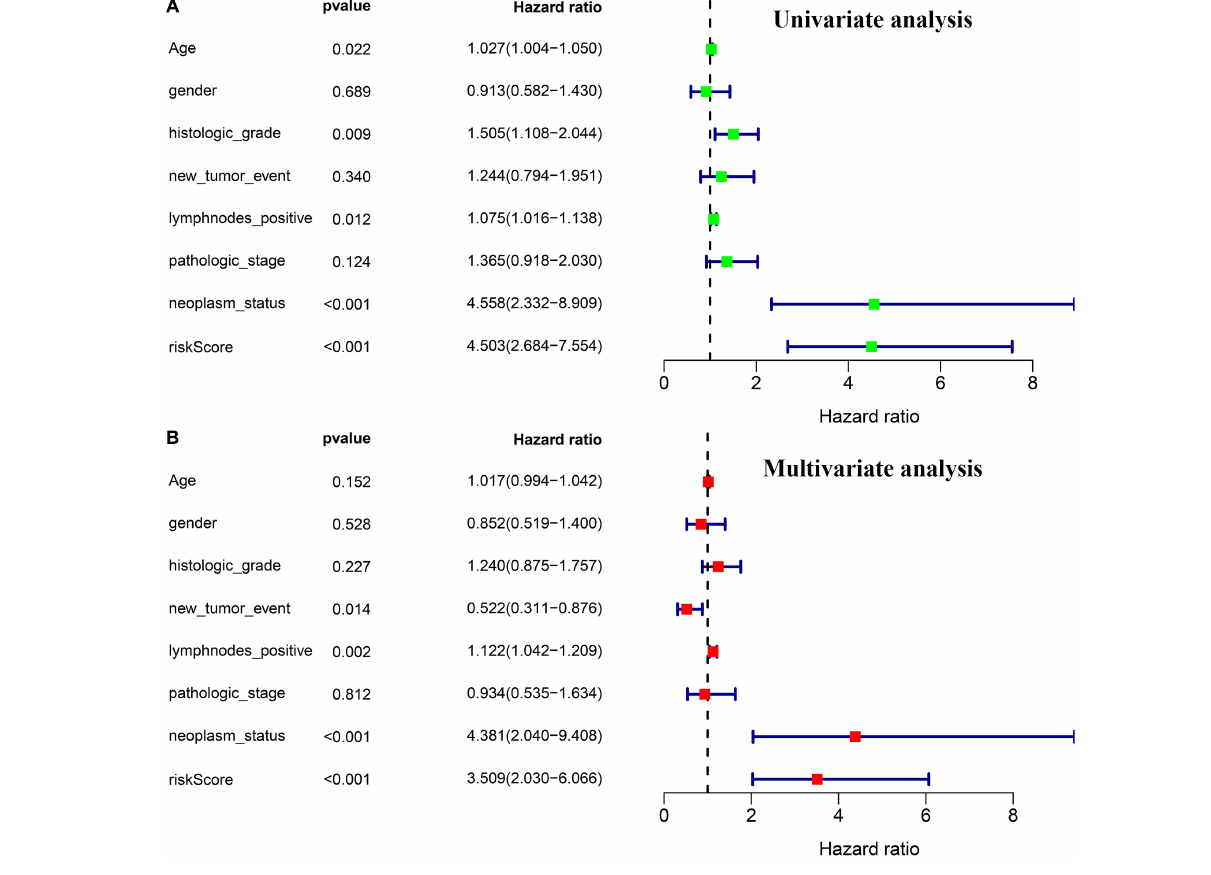
FIGURE 5 | Independence validation of the prognostic model and other clinical features. (A) Univariate Cox regression analysis. (B) Multivariate Cox regression analysis.